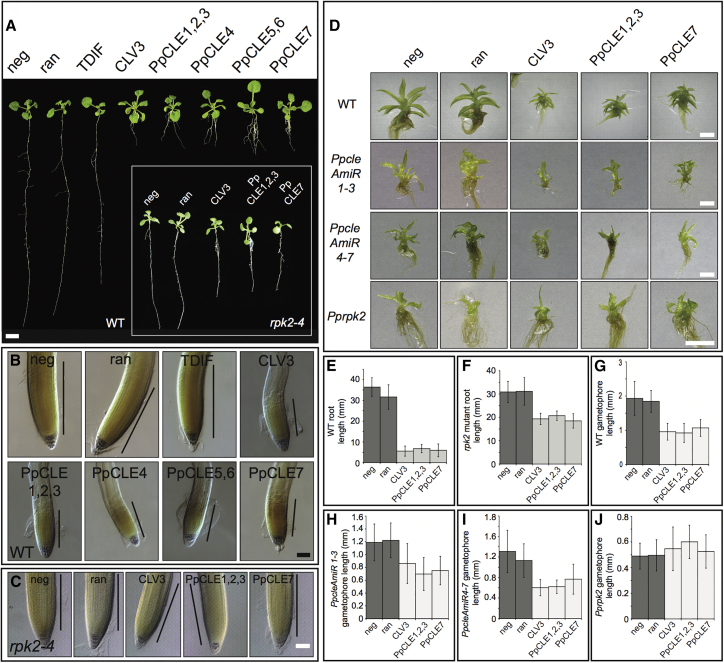
Physcomitrella CLE Peptides Act via a Conserved Receptor Machinery(A and B) Treatment of Arabidopsis seedlings with 1 μM CLV3-like CLEs from Arabidopsis and Physcomitrella, but not TDIF-like CLEs, suppresses root meristem proliferation in WT Arabidopsis (n = 30; ANOVA; Tukey’s HSD; p < 0.0005). The scale bar in (A) represents 1 cm and scale bar in (B) represents 100 μm; black bars in (B) represent approximate position and extent of root meristem.(C and inset in A) Arabidopsis rpk2-4 mutants are resistant to treatment with 1 μM CLE peptides; n ≥ 15; ANOVA; Tukey’s HSD; p < 0.0005. The scale bar represents 100 μm in (C).(D) Gametophores in plants treated with 10 μM CLEs are stunted in WT, PpcleAmiR1-3, and PpcleAmiR4-7 mutants, but not Pprpk2 mutants (n ≥ 20; ANOVA; Tukey’s HSD; p < 0.0005). The scale bar represents 100 μm.(E and F) Quantitative data on root length in WT (E) and rpk2 mutant plants (F), supporting inferences from images shown in (A).(G–J) Quantitative data on gametophore length in WT (G), PpcleAmiR1-3 (H), PpcleAmiR4-7 (I), and Pprpk2 (J), mutant plants supporting inferences from images shown in (D).